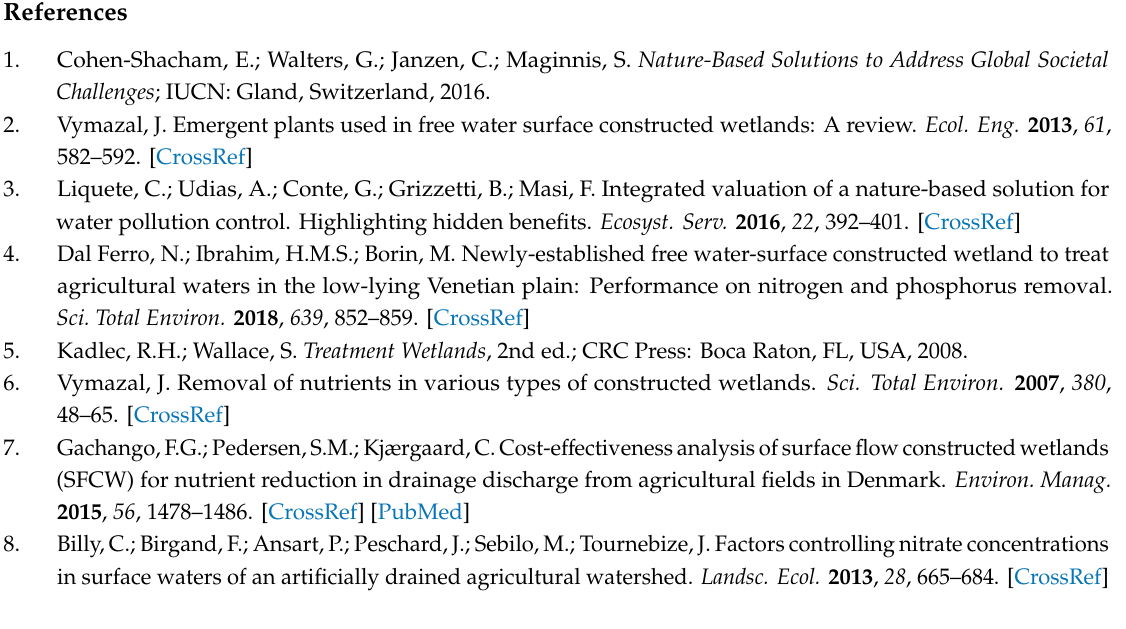
Table S1: Crop and fertilizer management of the agricultural fields delivering water to the